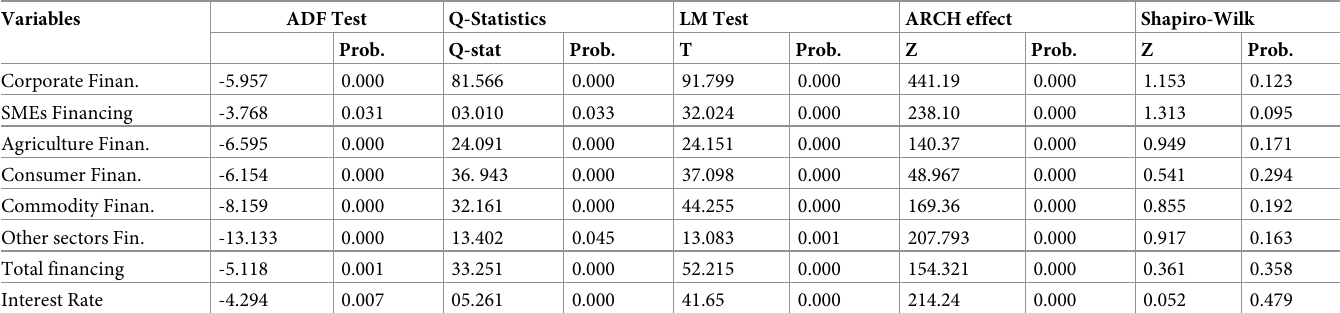
Table 6. Preliminary tests for DCC-GARCH